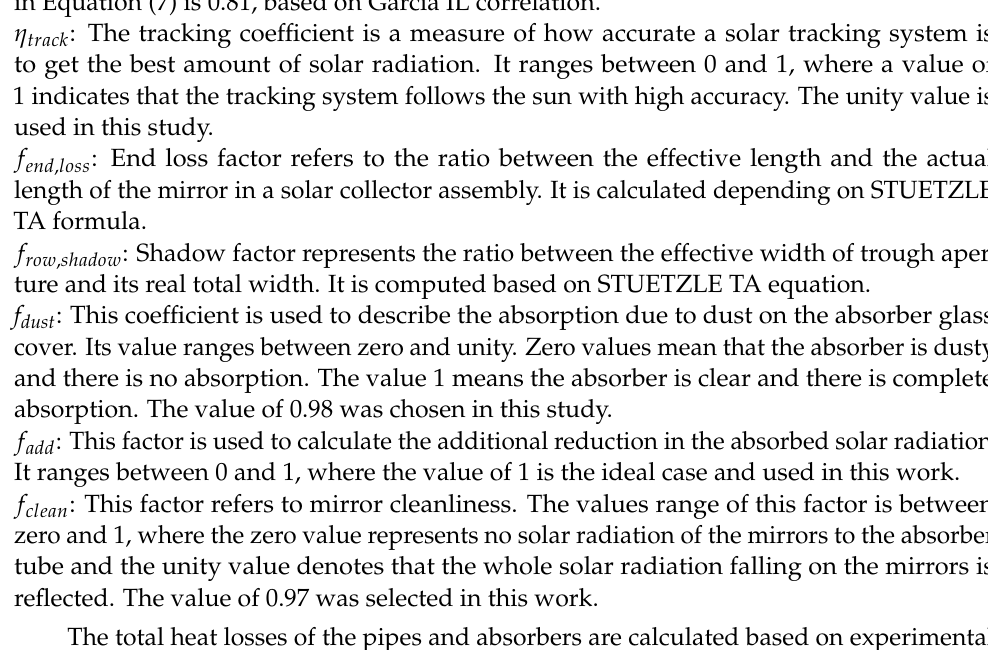
Figure 3. Solar field circuit.